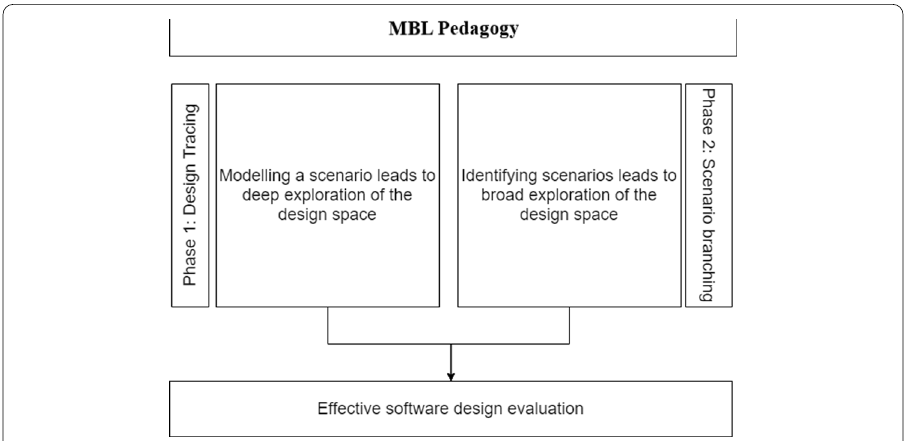
Fig. 3 The model-based learning (MBL) pedagogy for software design